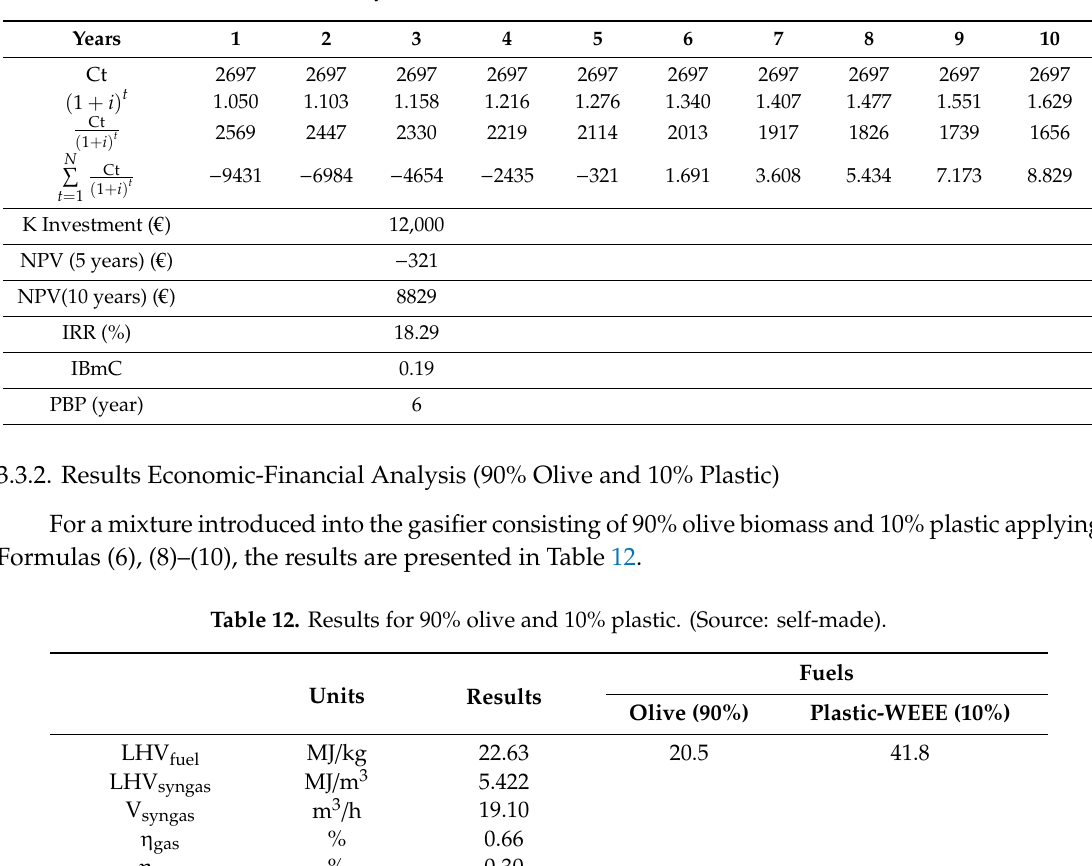
Table 11. Economic Analysis Results (100% olive biomass) (Source: own elaboration).